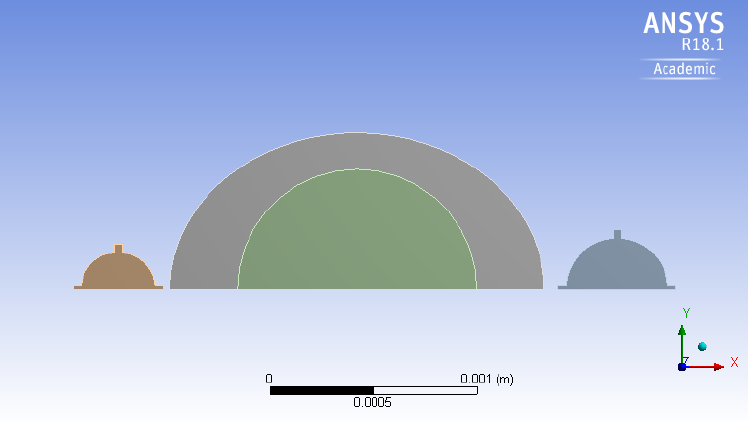
Figure 11. The elliptical chamber